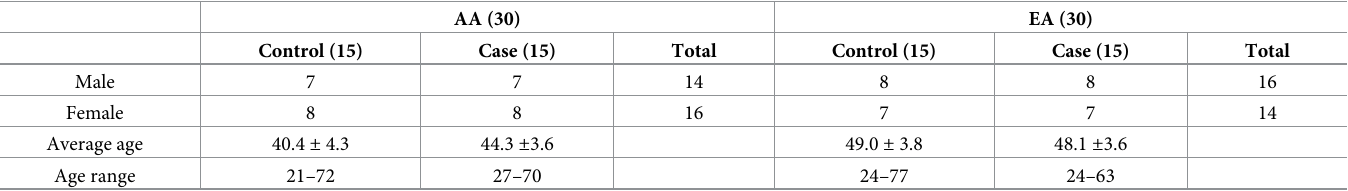
Table 1. Demographic information on 60 COGA subjects